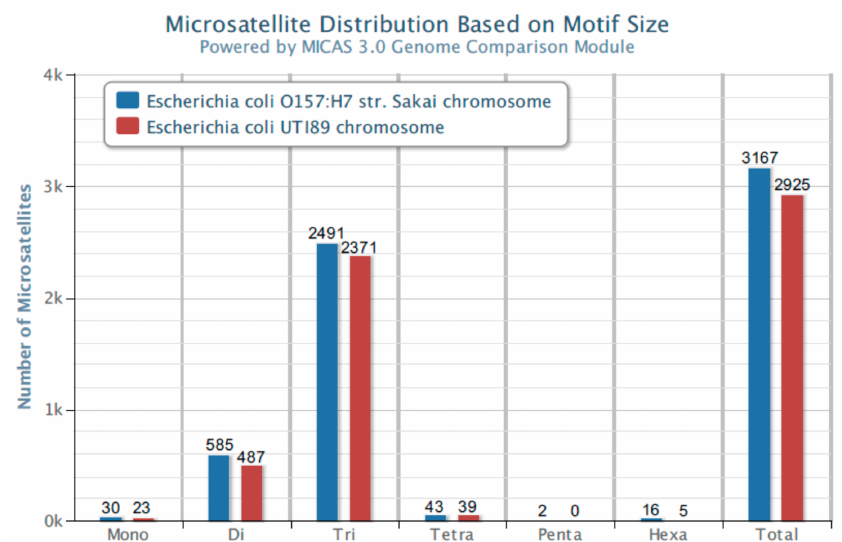
Figure 1. Microsatellite distribution in E. coli UTI89 and E. coli O157:H7 Sakai. Minimum Iterations: Mono—(9), Di—(4), Tri—(3), Tetra—(3), Penta—(3),